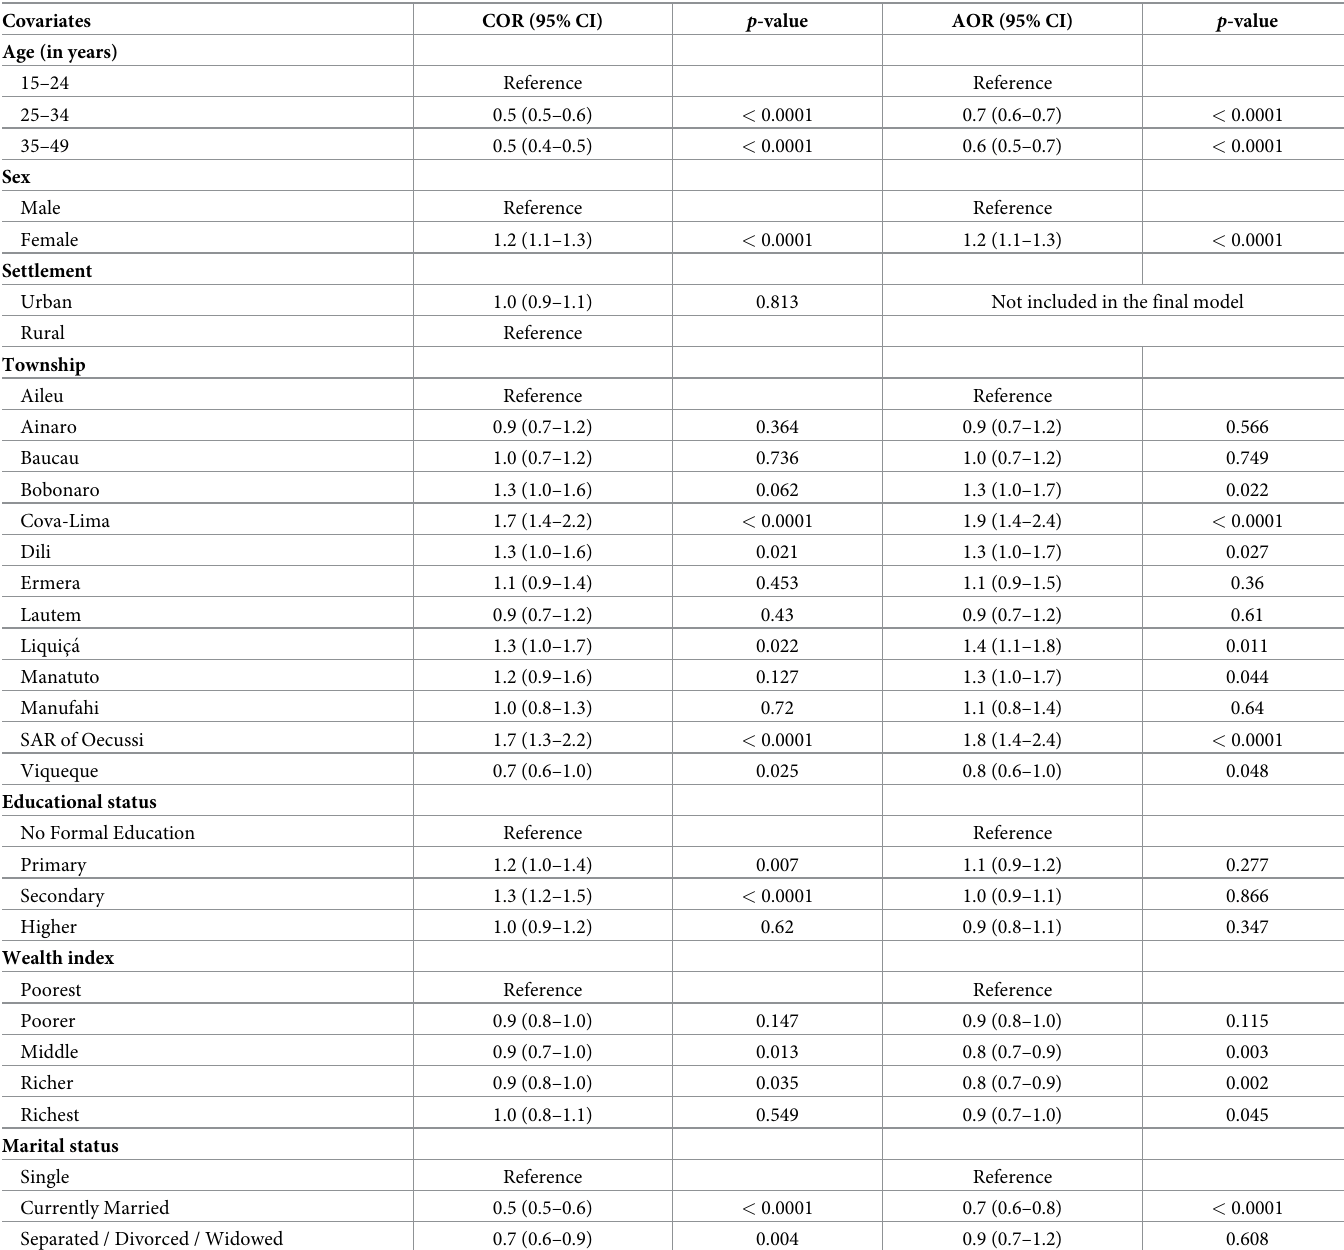
Table 2. Crude and adjusted odds ratio (95% CI) estimates of underweight compared to normal weight by respondent background characteristics, TLDHS 2016. Covariates COR (95%